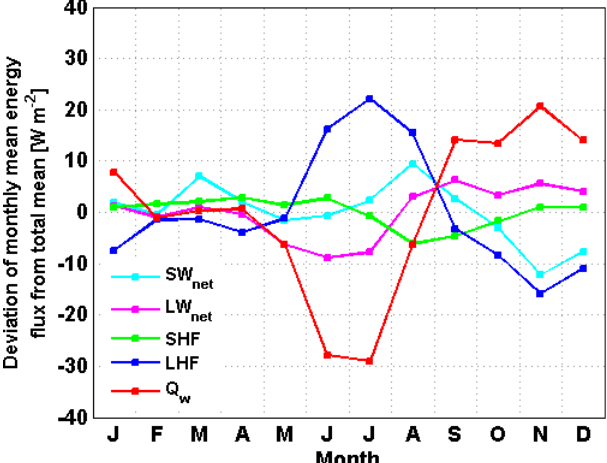
Fig. 15. Deviation of the monthly average of the surface energy balance components from its long-term mean (Wm − 2 ) at Ishungu, 2003–2011, calculated by FLake’s surface flux routines. Compo- nents are net short-wave radiation (SW net ), net long-wave radiation (LW net ), sensible heat flux (SHF), latent heat flux (LHF) and sub- surface conductive heat flux ( Q